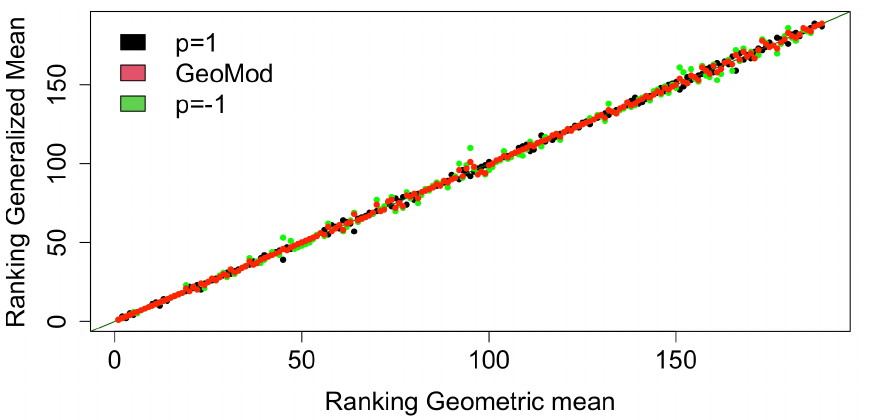
Figure 7. Scatter plot of the ranking obtained with the harmonic mean version of HDI (in green), with the arithmetic mean version of HDI (in black) and with the pHDI (in red) vs. the ranking obtained with HDI